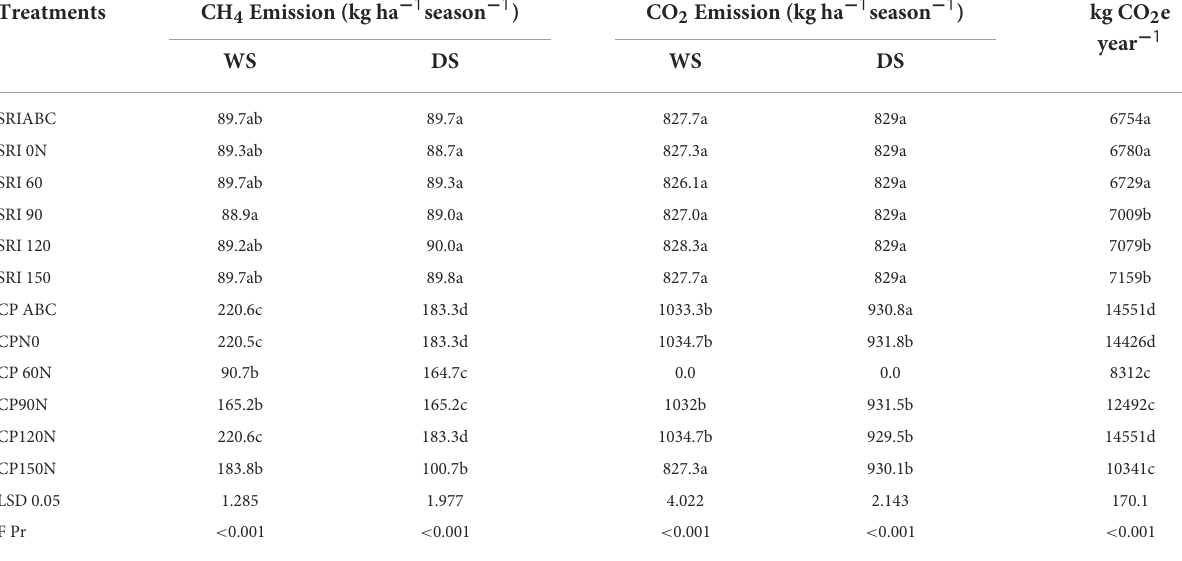
TABLE 9 Seasonal methane and carbon dioxide emission as influenced by crop management practices and nitrogen fertilization